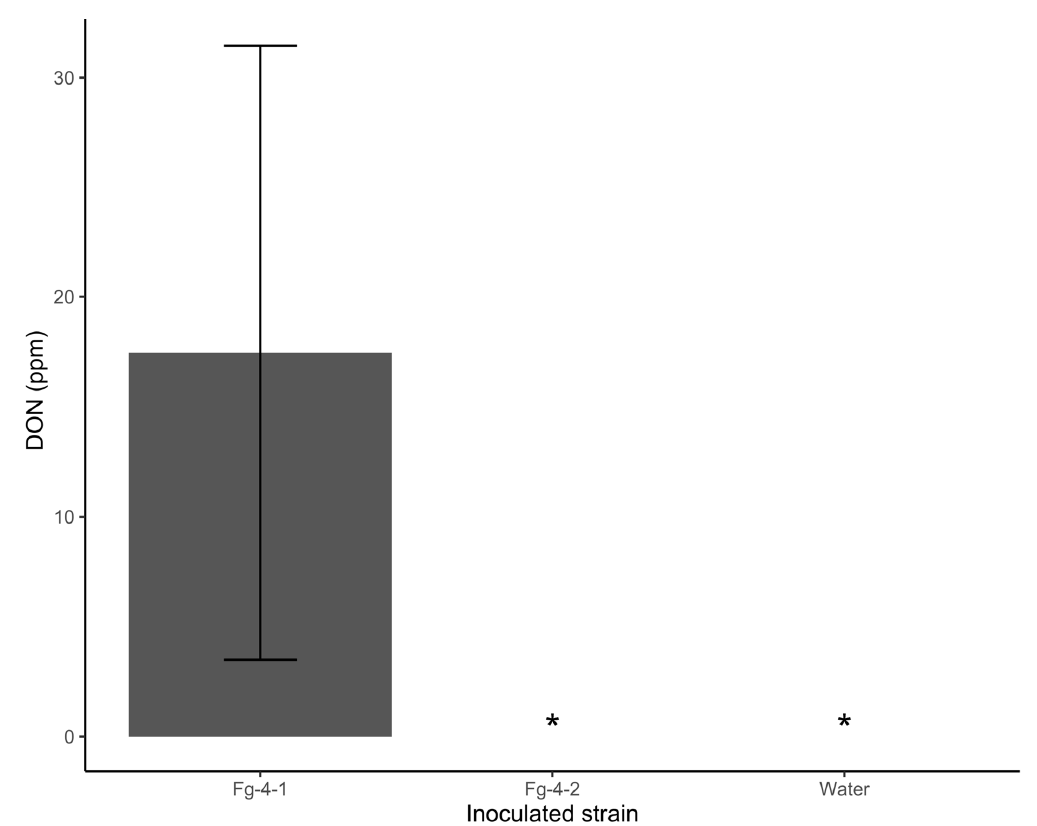
Figure 6. Deoxynivalenol (DON) toxin accumulation after inoculation of wheat line NIL-S with F. graminearum isolates Fg-4-1 and Fg-4-2, and sterile water. DON is accumulated in virus-free strain Fg-4-1; however, FgV1-SD4 infection appears to abolish DON production in strain Fg-4-2. * indicates DON undetected.